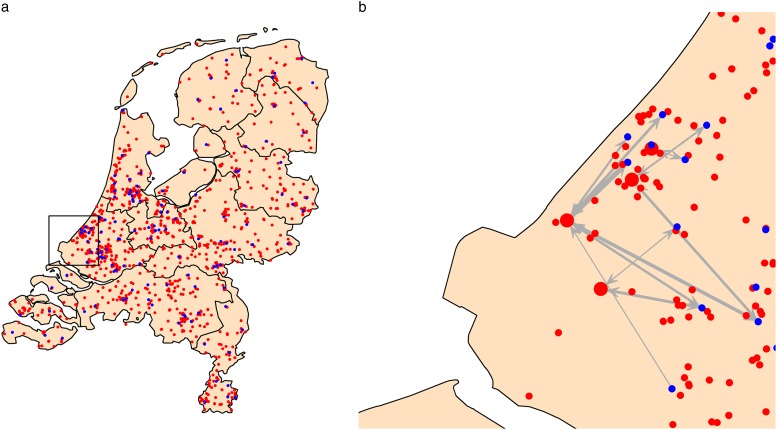
(a) Map of the Netherlands with the locations of hospitals (blue) and nursing homes
(red). (b) Example of the yearly simulated patient flow between 4 of the nursing
homes (large red dots) and the hospitals (blue).